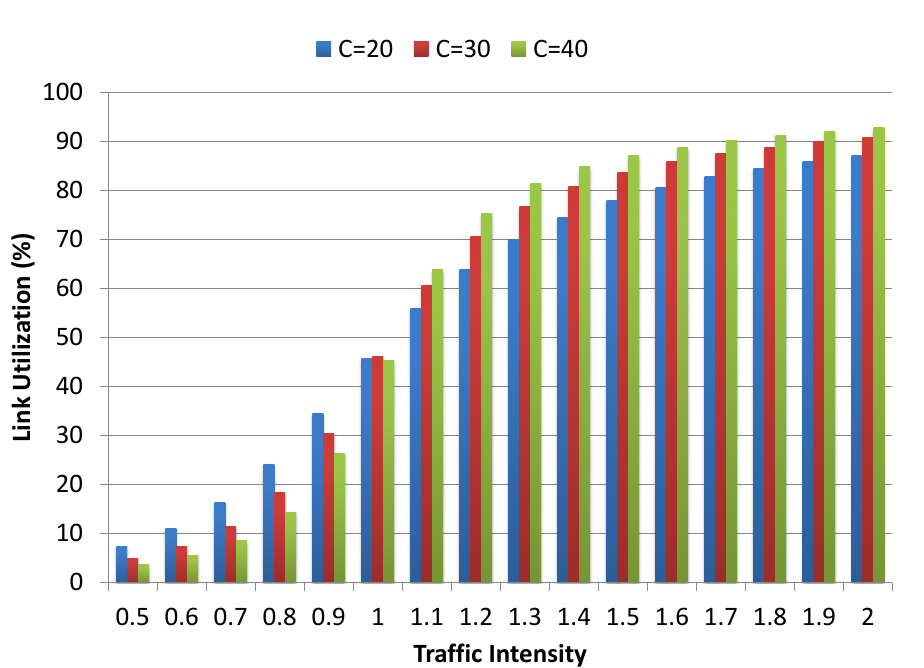
Figure 14. Percentage link capacity utilization by proposed model with varying traffic intensities for C = 20,30,40 Gbps.